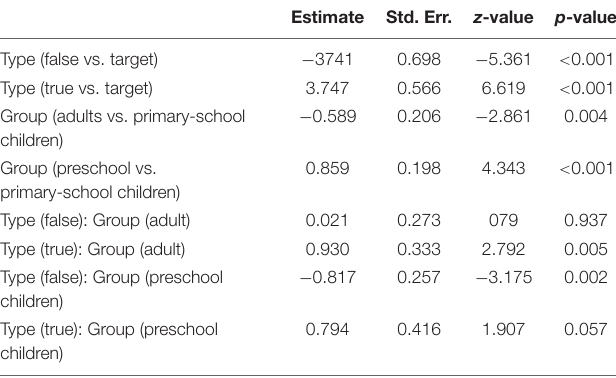
TABLE 3 | Output of the model with type of Medal as the dependent variable, Type (target items vs. False/True controls) and age Group as independent variables (with primary-school children as the baseline), and subjects and items as random intercepts. Estimate Std. Err. z -value p